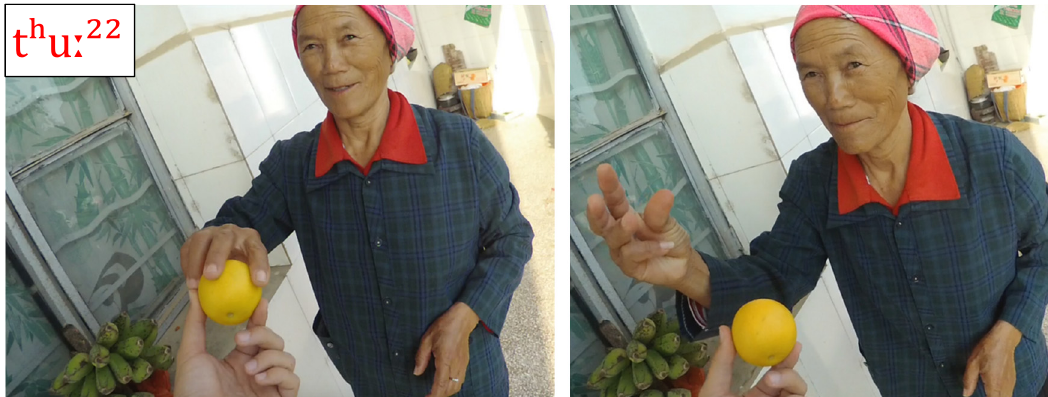
Figure 1: MSN shows orange size. Co - timed with disjoint deictic particle from